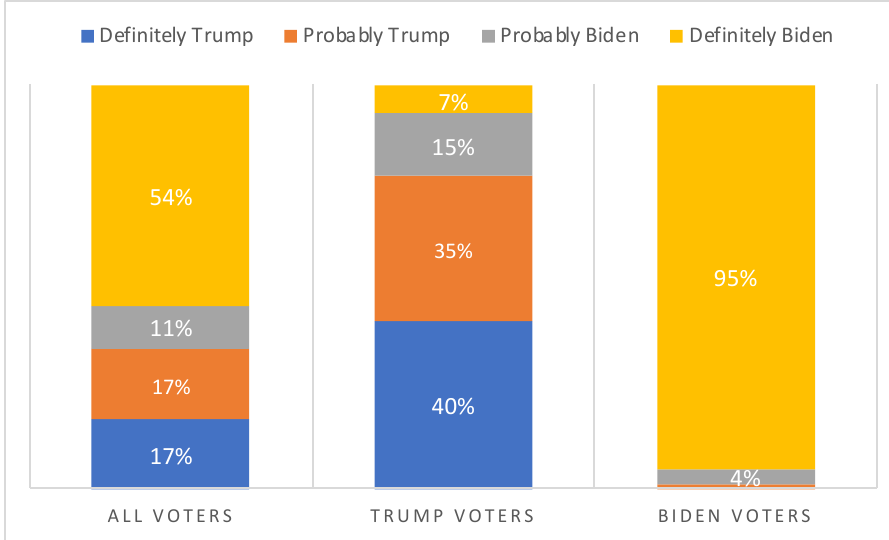
Figure 10. Percentage of Americans who incorrectly think Trump won the election. Source: Own elaboration from Pew Research’s American Trend Panel (2021).